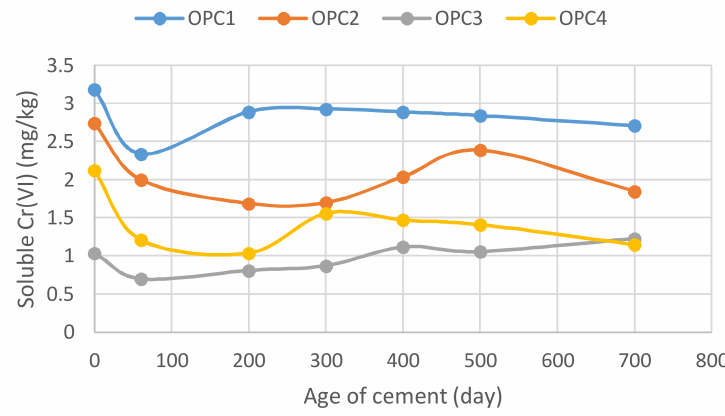
Figure 5. Cement age influence on Cr(VI) quantities leached from